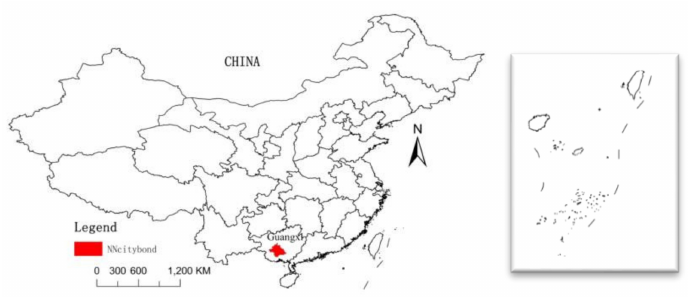
Figure 3. Location of Nanning